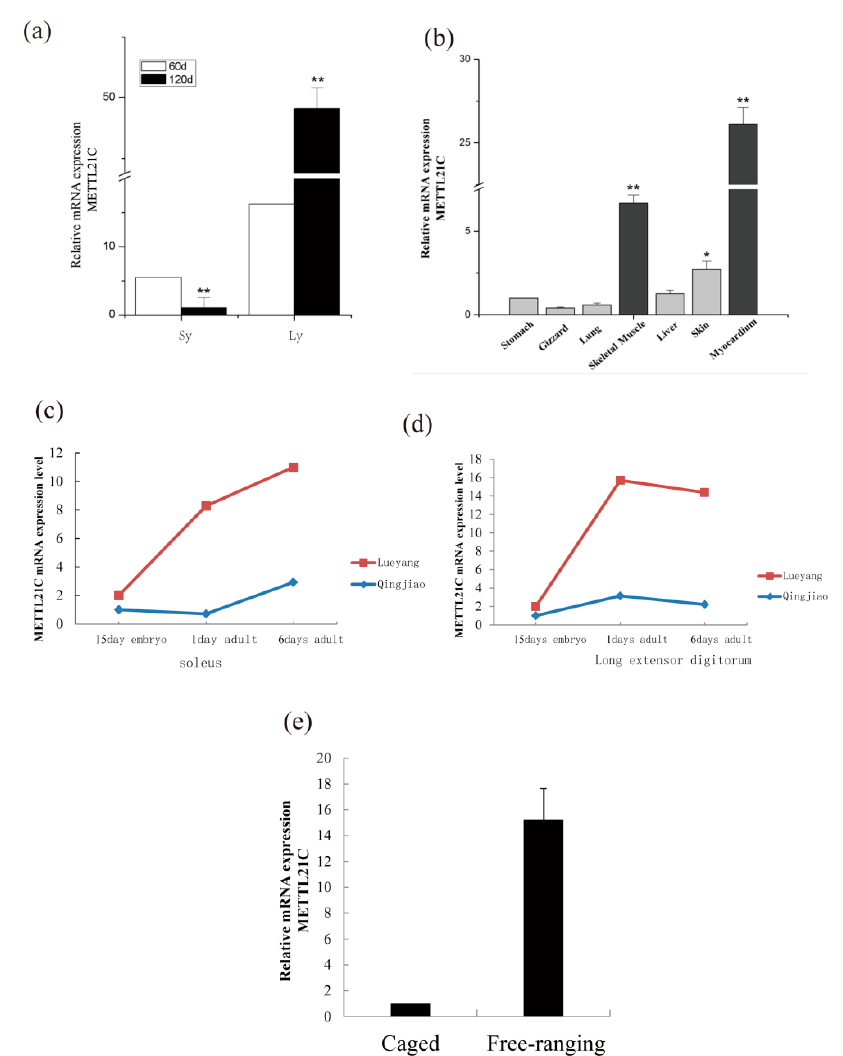
Figure 5. Relative mRNA expression: ( a ) METTL21C relative mRNA expression expression in different breeds of Sy and Ly chicken. ( b ) METTL21C relative mRNA expression in different tissues of Ly chicken. ( c ) METTL21C mRNA expression level in the soleus muscle. Lueyang represents Lueyang chickens and Qingjiao represents Qingjiao chickens. ( d ) METTL21C mRNA expression level in toe elongation muscles. ( e ) METTL21C relative mRNA expression in caged and free-ranging chickens.* p ≤ 0.05; ** p ≤